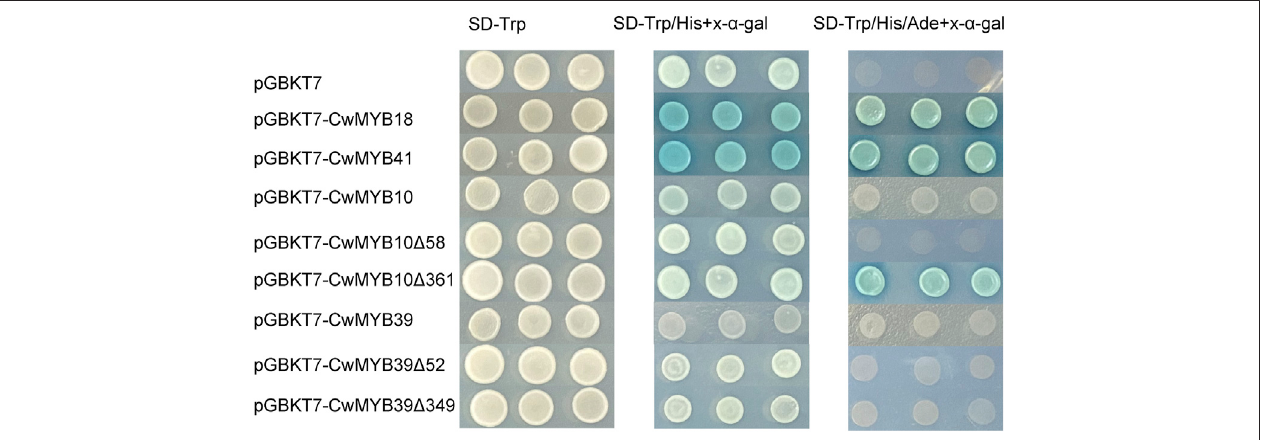
FIGURE 8 | Analysis of the transactivation activity of four candidates R2R3-type CwMYBs in yeast. Recombinant plasmids were transformed into yeast strain AH109, and the transformant strains were screened by SD/ − Trp, SD/ − Trp/ − His + X-a-gal, and SD/ − Trp/ − His/ − Ade + Xa-gal